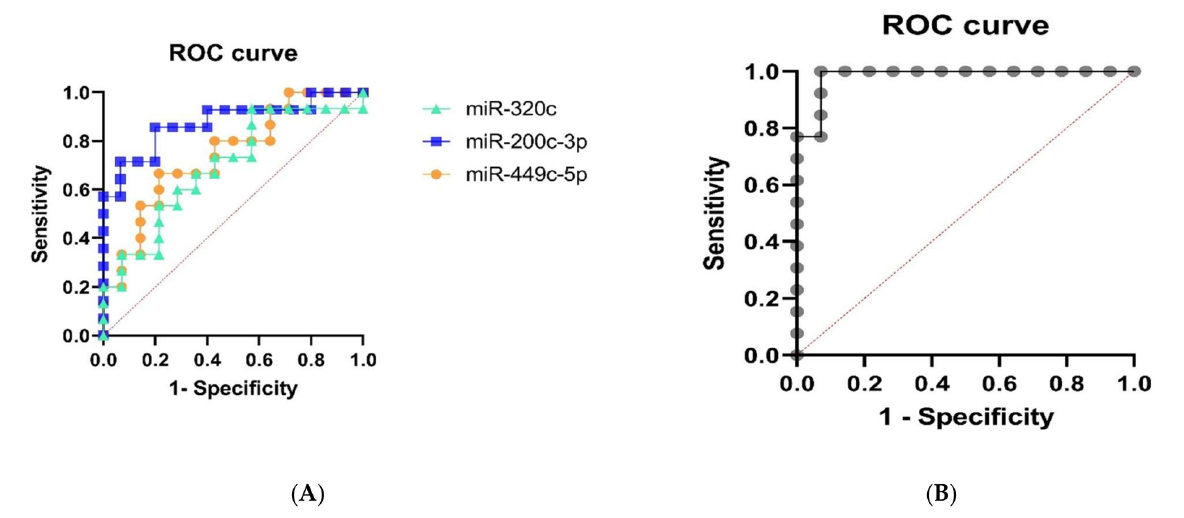
Figure 3. Receiver operating characteristic (ROC) curve for the individual mi-R-320c (AUC = 0.69), miR-200c-3p (AUC = 0.87), and miR-449c-5p (AUC = 0.74) ( A ) and for the logistic regression model (AUC = 0.89) ( B